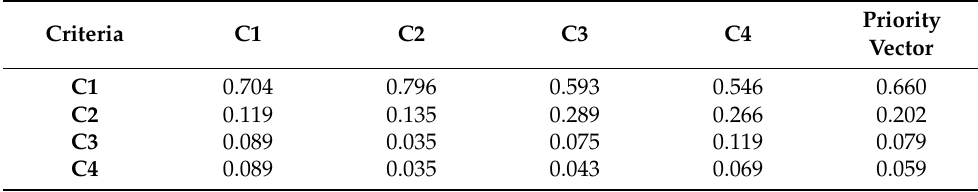
Table 9. Main criteria normalization comparison matrix and priority